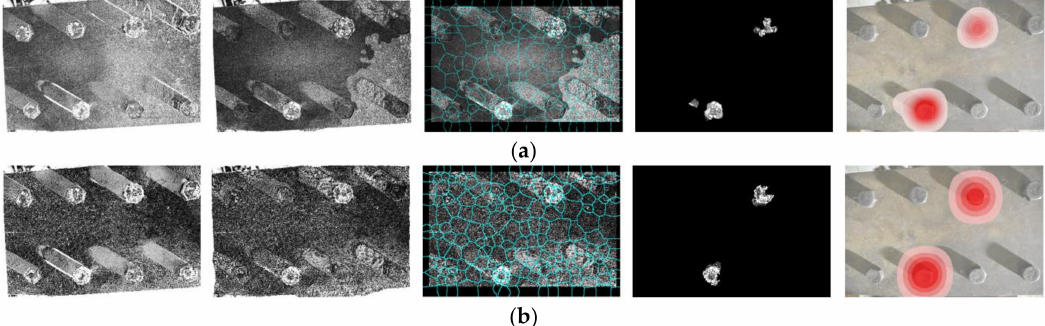
Figure 11. Comparison of bolt loosening detection results with input image resolutions of ( a ) 6000 pixels × 4000 pixels and ( b ) 750 pixels × 500 pixels. Five columns of Figure 11 represent (1) errors of feature-based image registration; (2) errors of intensity-based image registration; (3) superpixel segmentation; (4) feature enhancement; and (5) final result. The brightness of the images in the first to fourth columns is enhanced for demonstration purposes.